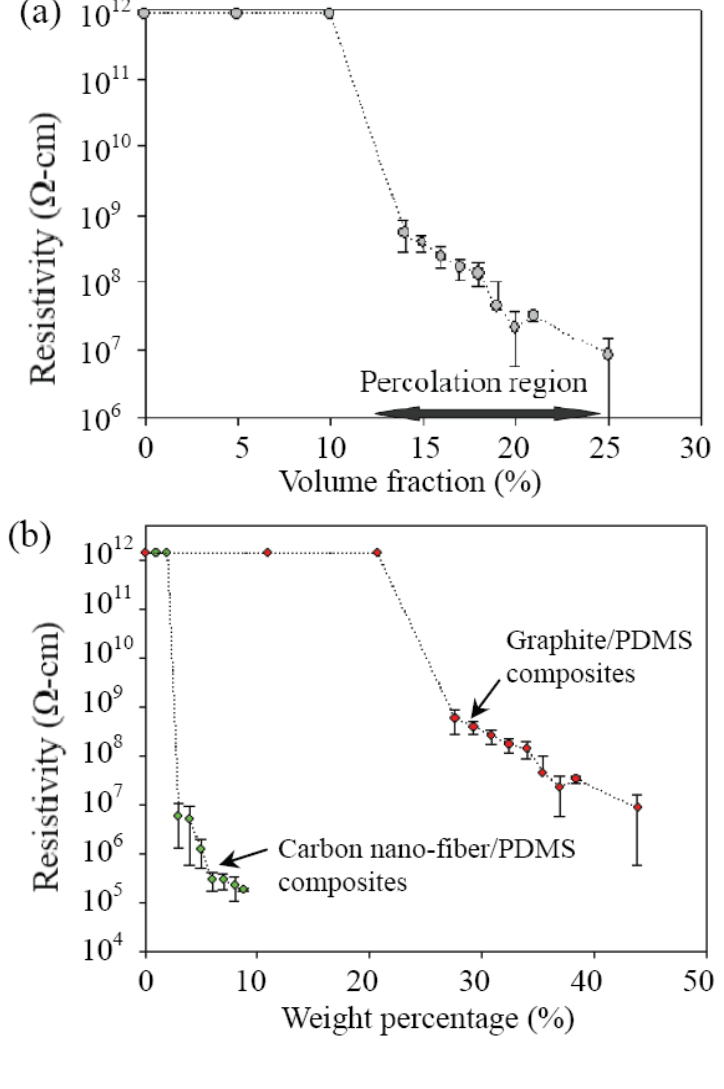
Figure 3. (a) Percolation threshold of graphite/PDMS composites. (b) Resistivity of graphite/PDMS and carbon nano-fiber/PDMS composites at different weight percentage of the conductive